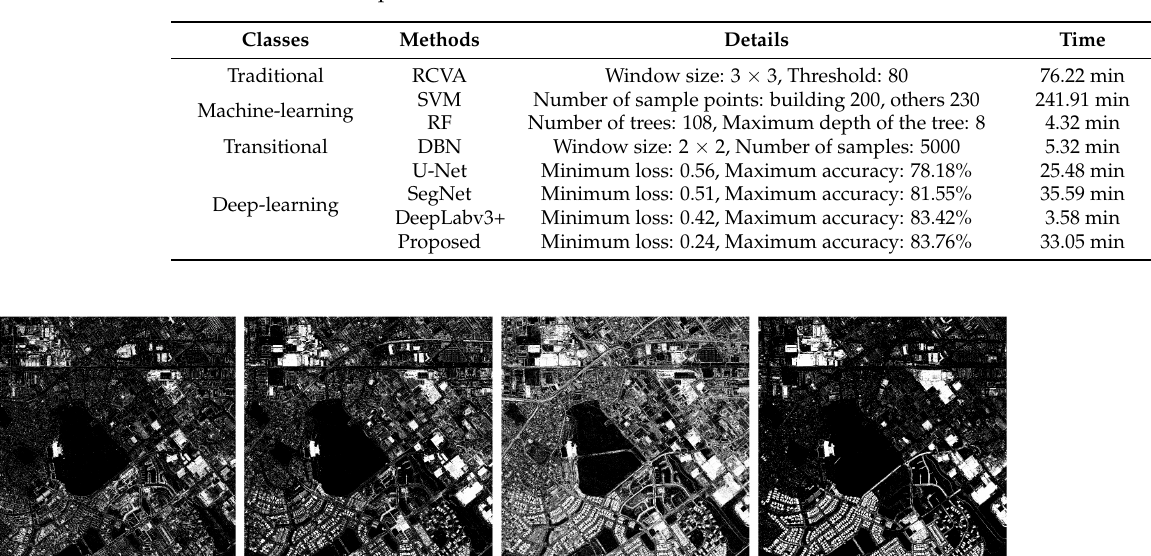
Table 2. Details of experiment 1. Table 3. Details of experiment 2.